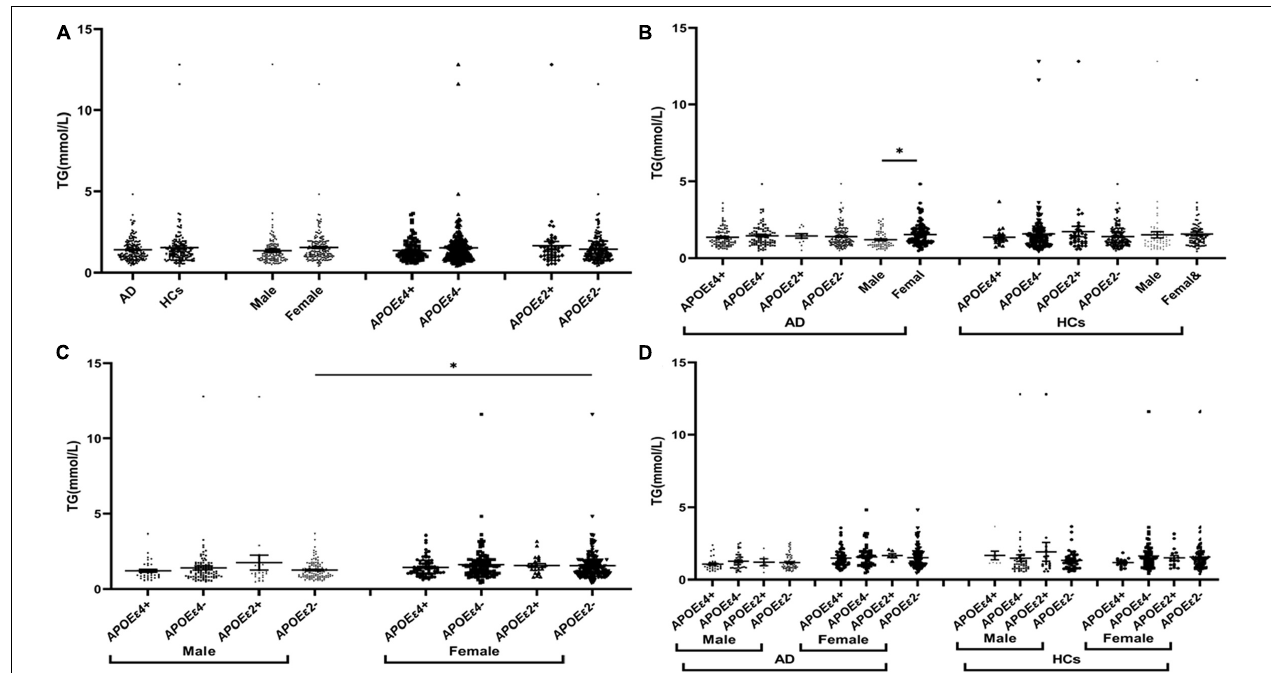
FIGURE 1 | The levels of TG in different populations. ∗ P < 0.05; Values are expressed as mean (standard error). AD, Alzheimer’s disease; HCs, healthy controls; APOE ε 4 +, APOE ε 4 carriers; APOE ε 2 +, APOE ε 2 carriers.